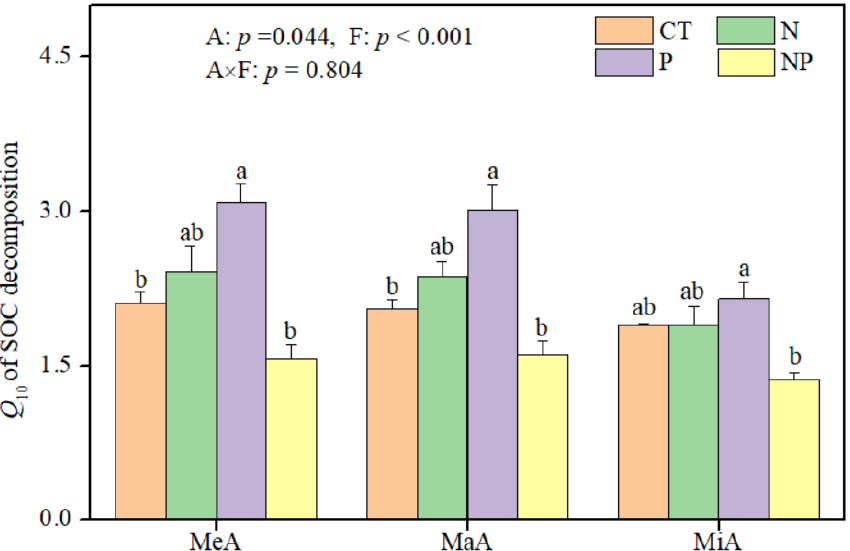
Figure 2. Effects of N and P fertilization on temperature sensitivity ( Q 10 ) of soil organic carbon (SOC) decomposition in different size aggregates after over 30 days of incubation in a subtropical forest. F and A represent fertilization and soil aggregate size, respectively. Different letters on the bars denote significant differences among fertilization treatments. MeA, MaA, and MiA represent mega-aggregates (>2.0 mm), macroaggregates (0.25 – 2.0 mm), and microaggregates (<0.25 mm). Data were represented as the mean with standard error.